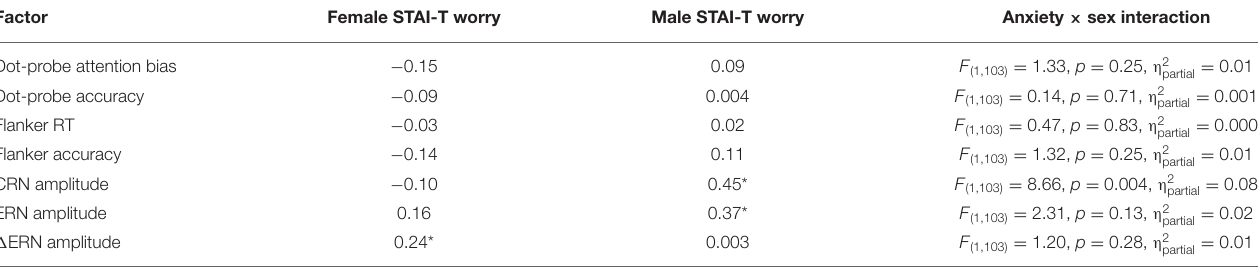
STAI, State Trait Anxiety Inventory; ERN, error-related negativity; CRN, correct-related negativity; 1 ERN, difference score between ERN and CRN. * Indicates bivariate pearson correlation p <